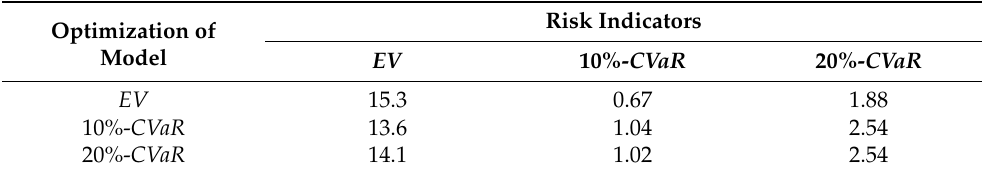
Table 3. Results from different conservative approaches.